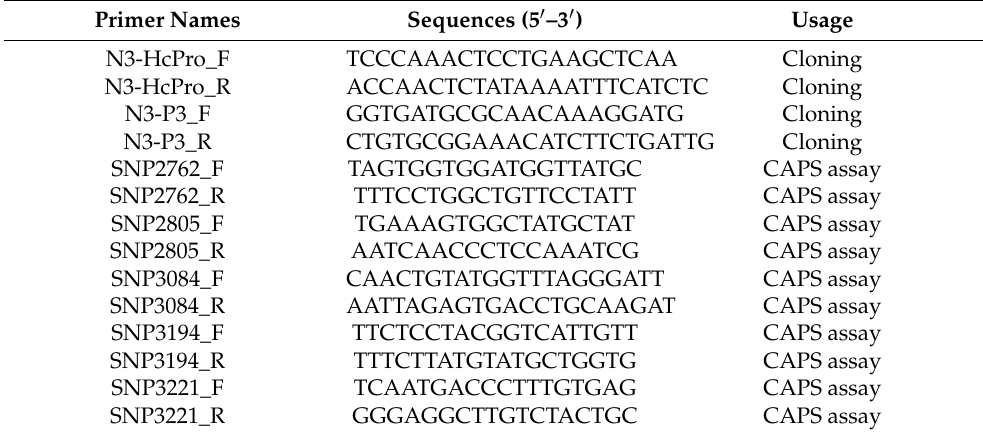
Table 1. Primers used in the present